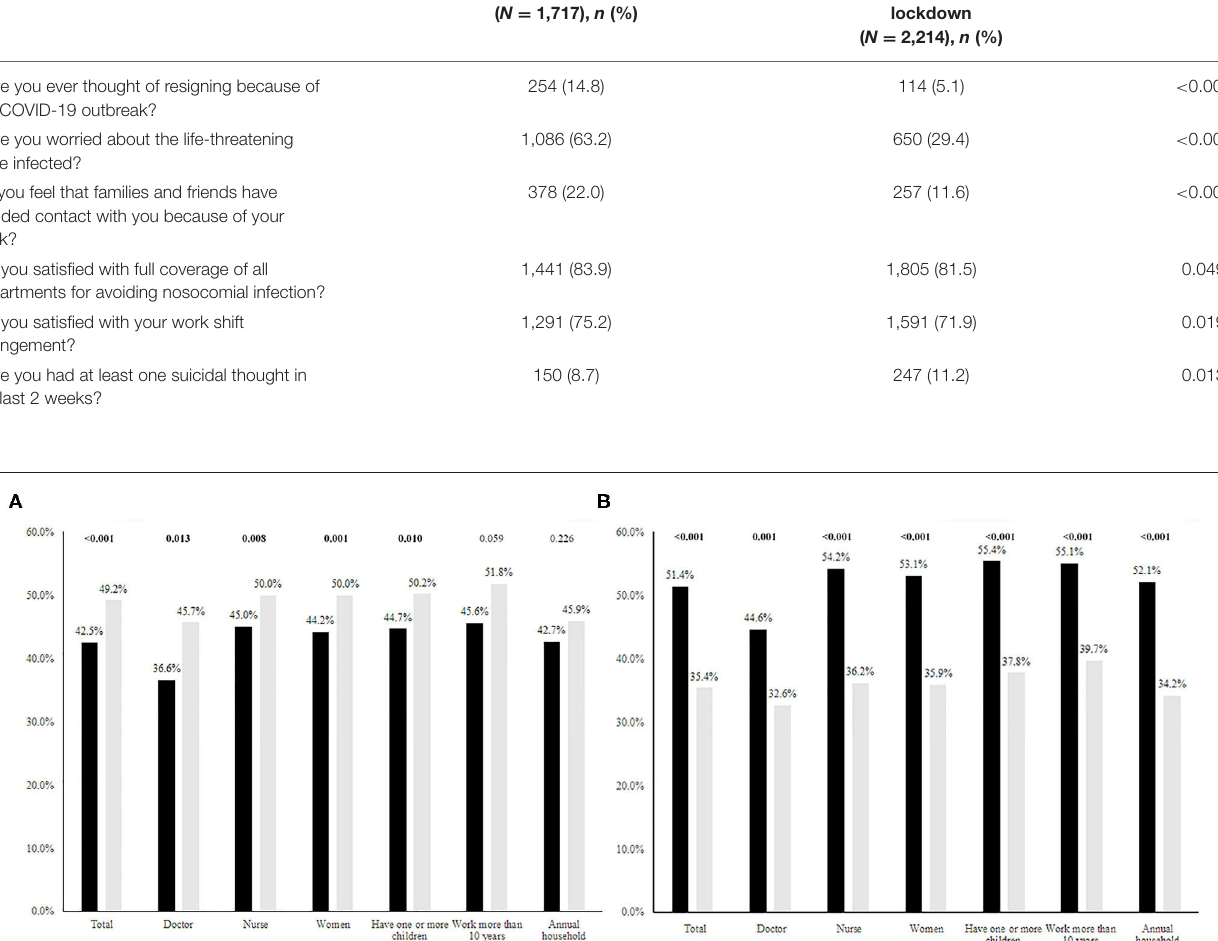
TABLE 2 | Perceptions of threat of the COVID-19 among front-line HWs dealing with the COVID-19 in two phases. Characteristics